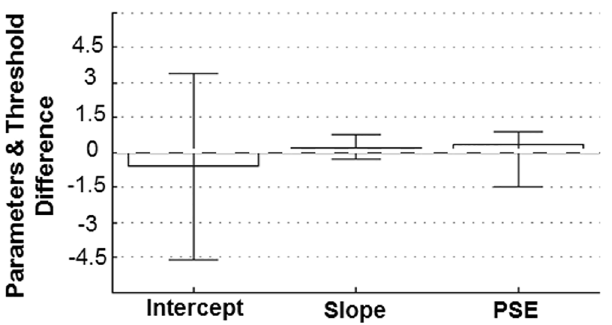
Fig 4. Psycho-metric vs Muscle-metric Parameters Similarity. Concordance between the shape of the psycho and muscle metric curves as well as between thresholds. Each bar shows the across subjects averaged difference values (perceptual — muscular) between the psychometric and muscle-metric datasets with 95% confidence intervals (CI). Zero difference values (horizontal dashed line) indicates a perfect match between psychometric and muscle-metric curves as well as relative thresholds. PSE difference below zero indicates that muscles tended to have higher thresholds than perceptual ones. Curve parameters difference mean value and CIs were averaged across 9 subjects (those with R 2 merged > 0.5 and R 2 psy (cid:4) 0.6, Tables 1 and 2). PSE differences were averaged across 11 subjects ( R 2 merged > 0.5, values in bold Table 2) whose thresholds and CIs were calculated by considering PSE values from reversals when R 2 psy was lower than